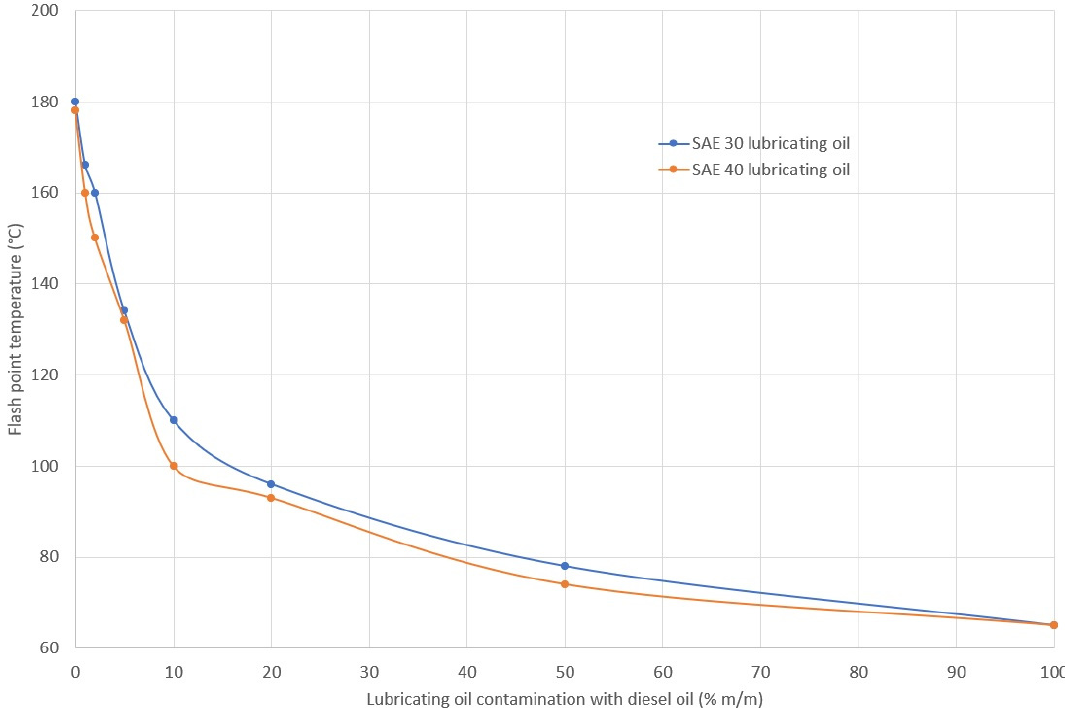
Figure 22. Flash point temperature determined in a closed crucible for the lubricating oils tested at different levels of lubricating oil dilution with diesel fuel.